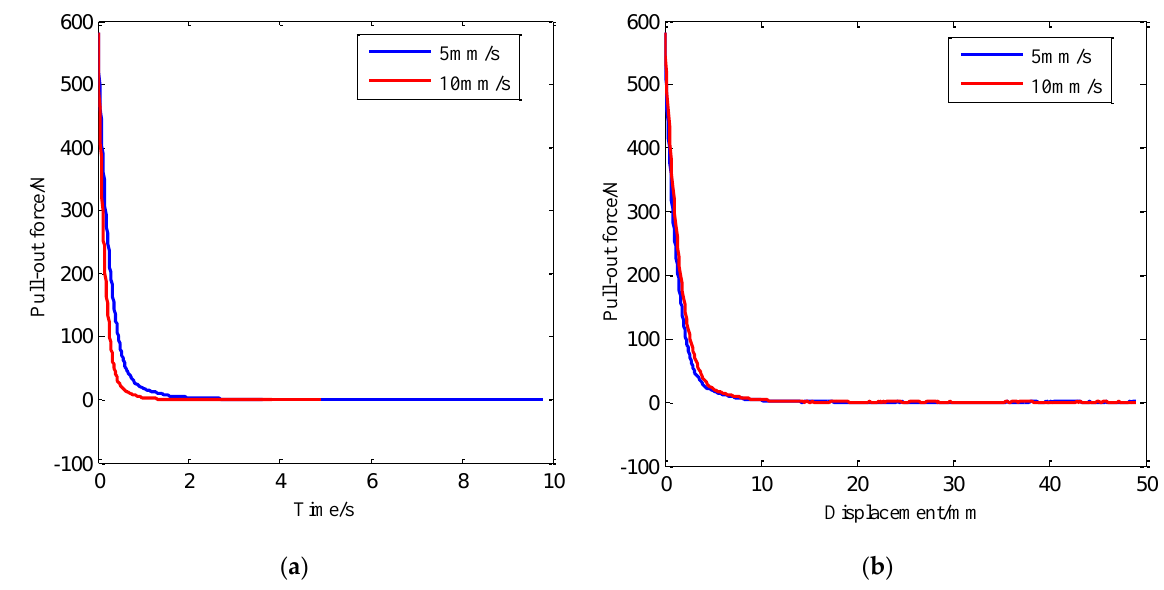
Figure 15. Pull-out force in simulation. ( a ) Force – time curve; ( b ) Force – displacement curve.